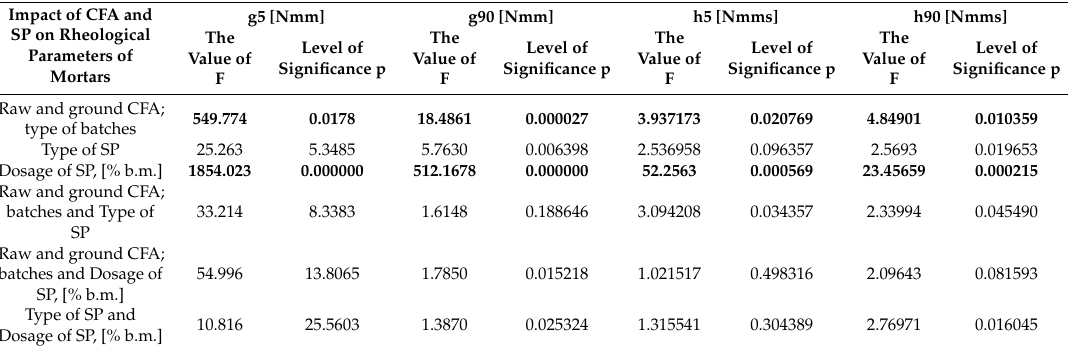
Table 10. ANOVA. One-dimensional significance tests for rheological parameters of mortar with